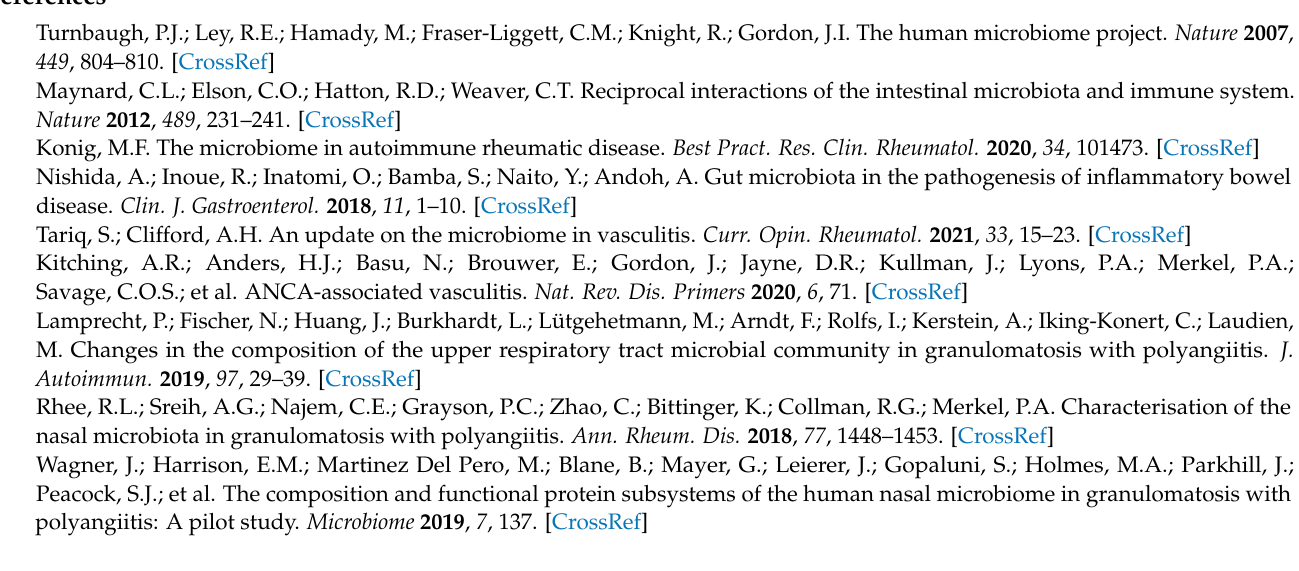
Supplementary Table S5: (A) Genera differing between 11 individuals with acute AAV and no an- tibiotic treatment for the previous 3 months and controls ( n = 23) using OPLS-DA analysis. The OPLS-DA model explained 45% and predicted 17% of the variation. (B) Species differing between 11 individuals with acute AAV and no antibiotic treatment for the previous 3 months and controls ( n = 23) using OPLS-DA analysis. The OPLS-DA model explained 12% and predicted 9% of the varia- tion. Variables with a VIP > 1.2 are listed, and orange color indicates taxa with increased abundance/ prevalence in acute AAV and blue color taxa with increased abundance/prevalence in